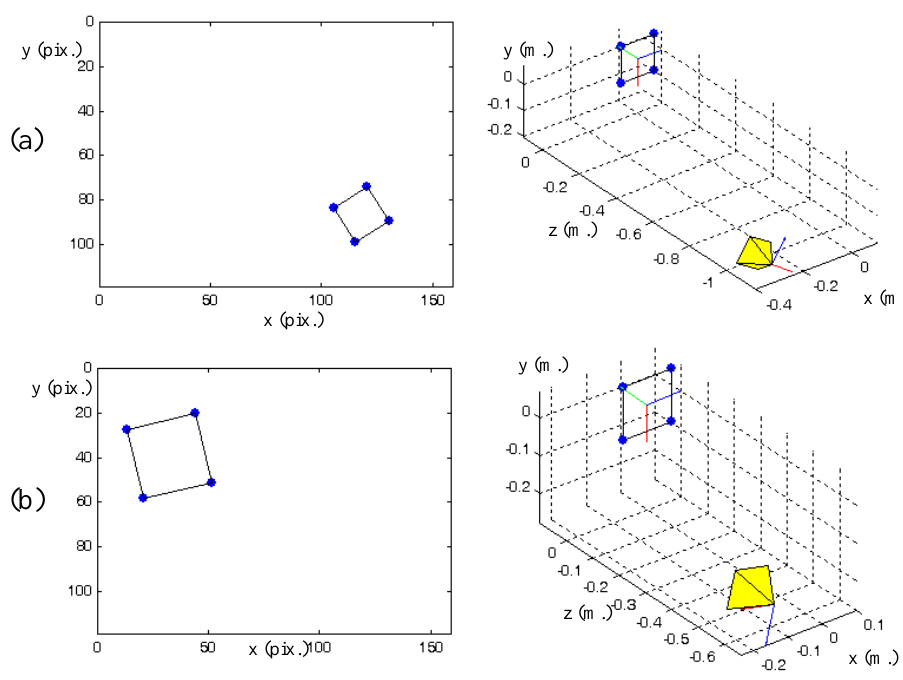
Figure 15. (a) Initial position of the image features and the eye-in-hand camera. (b) Final position of the image features and the eye-in-hand camera. Experiment 3.